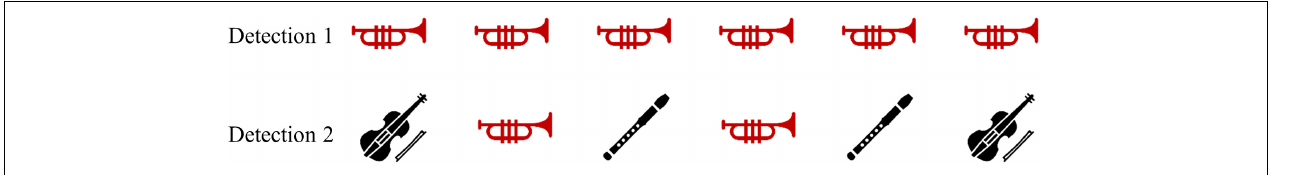
FIGURE 1 | An example of six trials of detection level 1 (Top) and detection level 2 (Bottom) . Both examples show a “trumpet block” in which the participant reacts to the trumpet melody. Red icons represent trials in which the participant was required to respond with a click when hearing the melody, indicating a “yes” response.